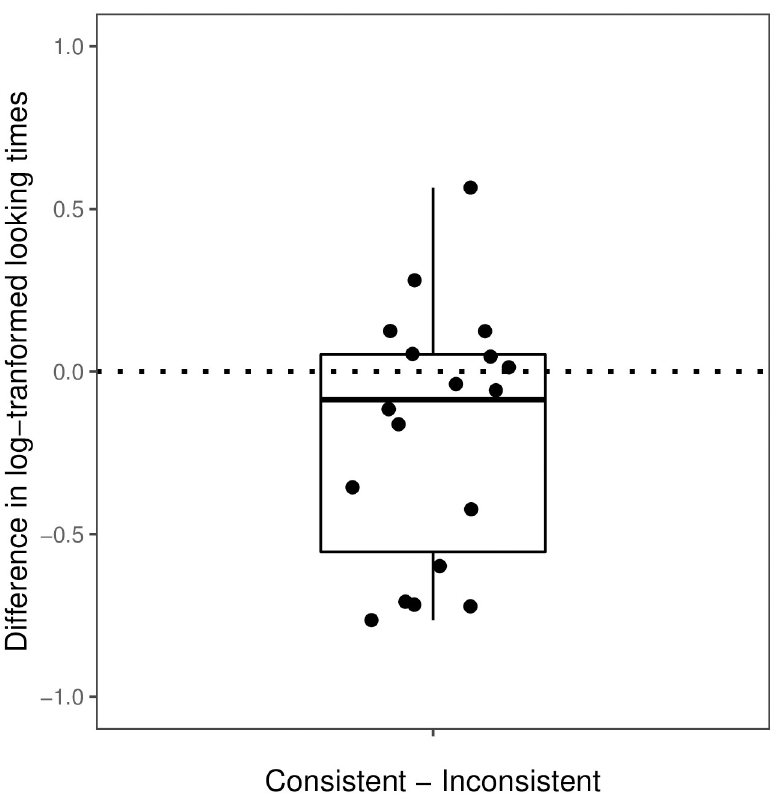
Fig 3. By-subject mean difference in log-transformed looking times between consistent and inconsistent test trials in Experiment 1.